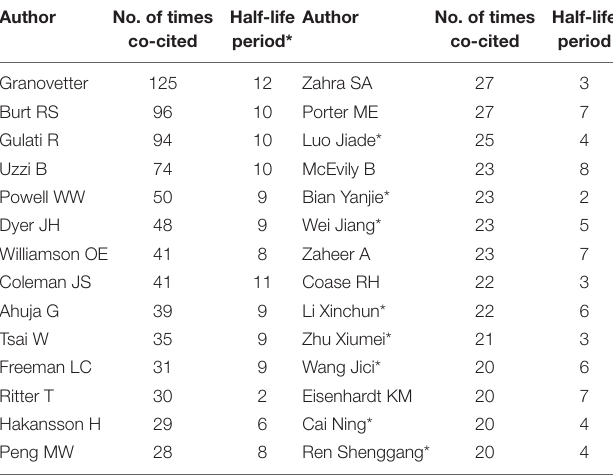
TABLE 4 | List of authors with high frequency of co-citation.